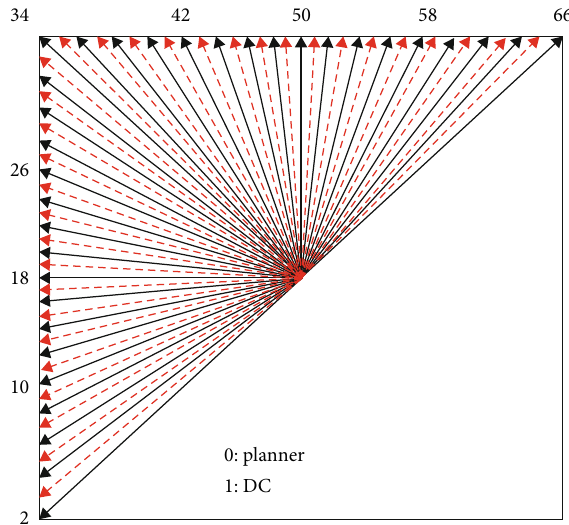
Figure 4: Intra prediction